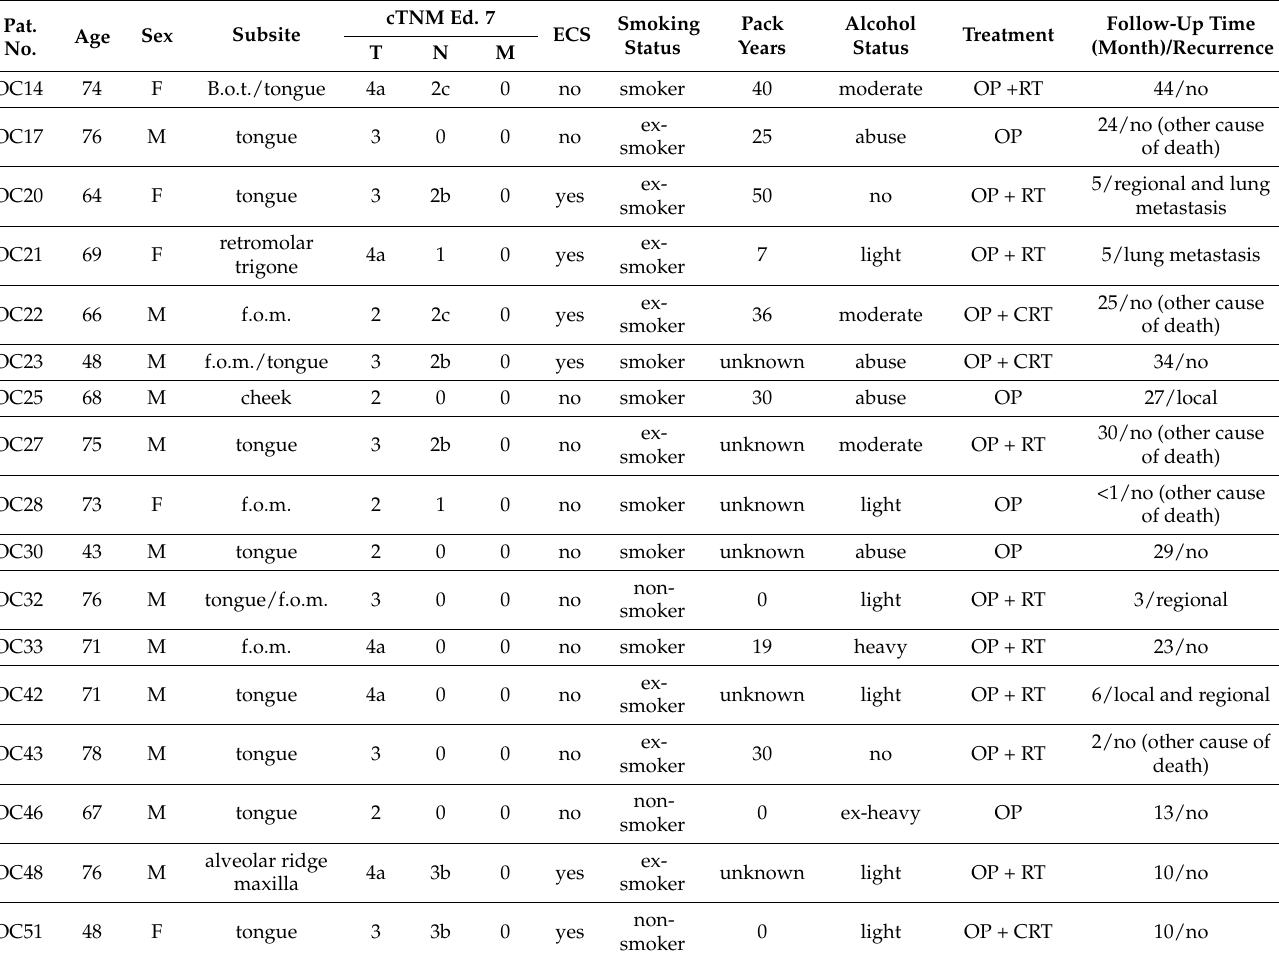
Table 1. Clinical patient characteristics. For tumor stage, 7th Edition AJCC TNM staging system